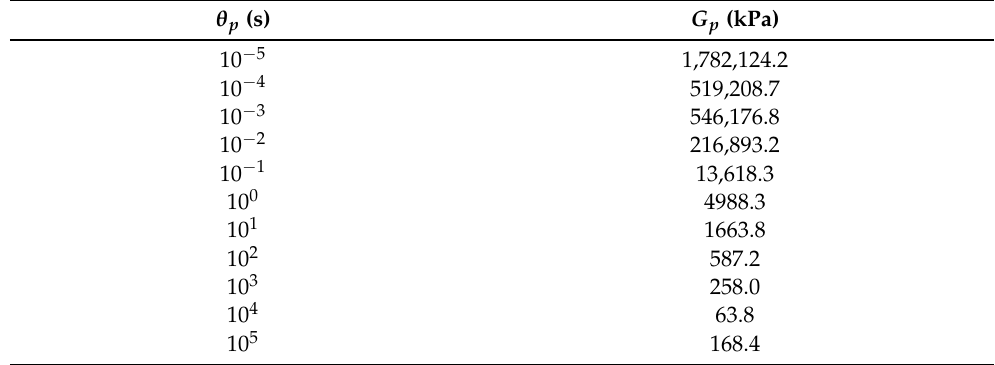
Parameters for the generalized Maxwell model with the long-term shear moduli G ∞ = 232.26 kPa for TROSIFOL BG R20 (Trosifol, Germany; PVB-based foil) for T 0 = 20 ◦ C ( C 1 = 8.635, C 2 = 42.422 ◦ C) from